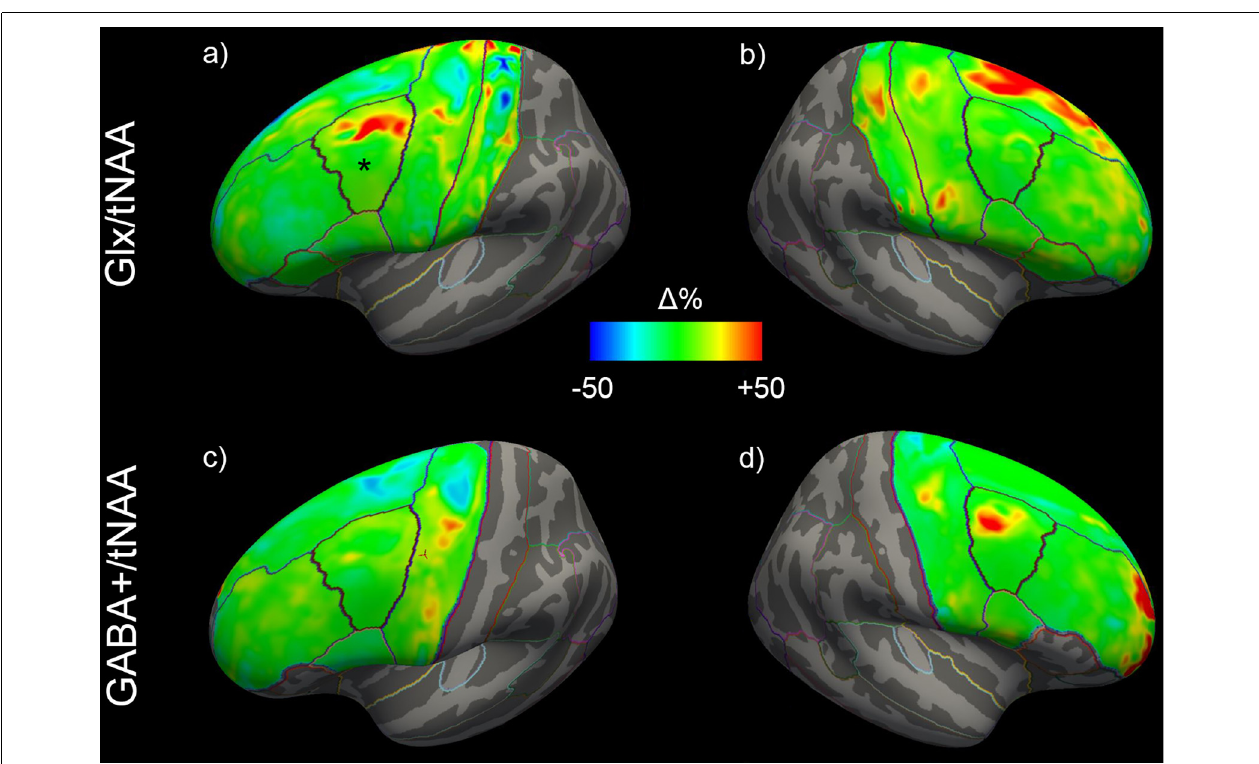
FIGURE 4 | Mean changes of Glx/tNAA and GABA+/tNAA ratios of the left (A,C) and right (B,D) hemisphere across all study participants. The left caudal middle frontal area in (A) , showing significant changes, is marked with a *. Glx, combined measure of glutamate and glutamine; tNAA, total N-acetylaspartate; GABA+, a combination of GABA and